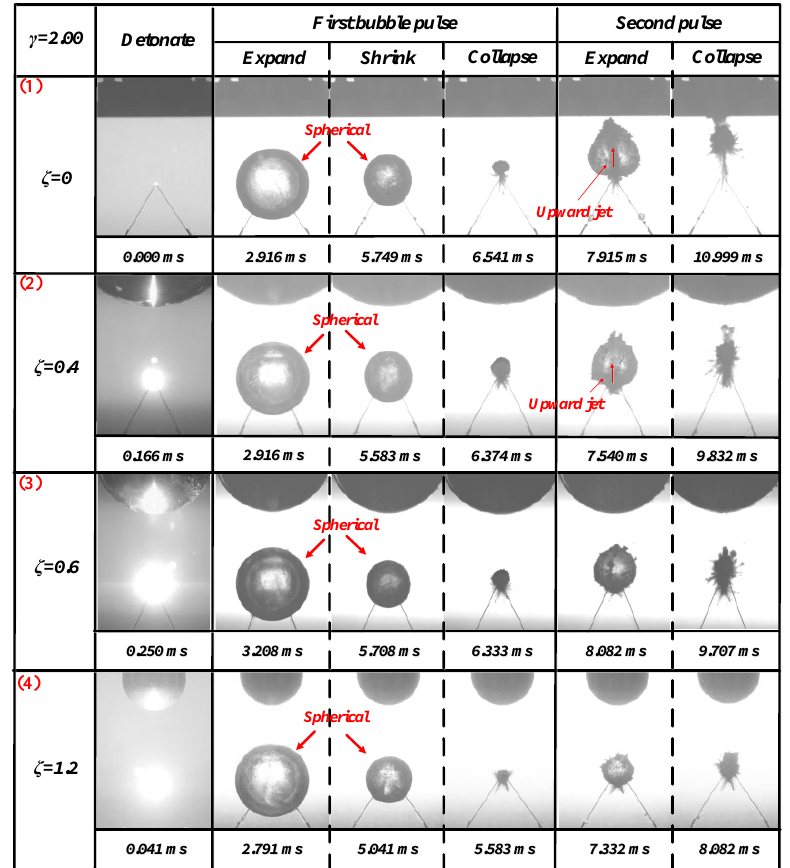
Figure 13. Bubble morphological changes under the influence of di ff erent ζ values. The first row shows the bubble’s morphological changes when ζ = 0 and γ = 2.00. The second row shows the bubble’s morphological changes when ζ = 0.4 and γ = 2.00. The third row shows the bubble’s morphological changes when ζ = 0.6 and γ = 2.00. The fourth row shows the bubble’s morphological changes when ζ = 1.2 and γ =